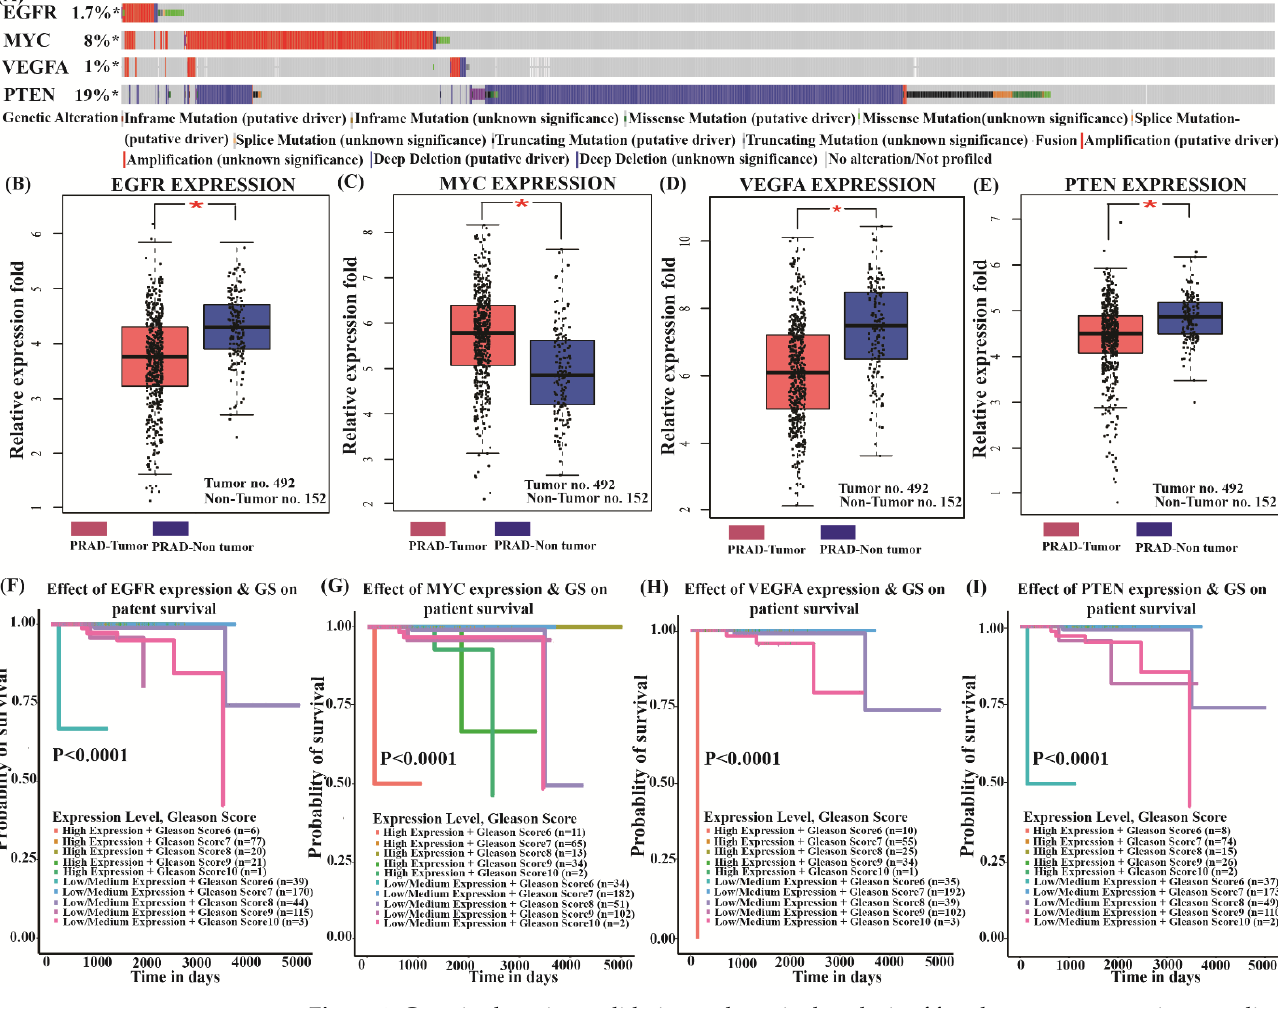
Figure 8. Genetic alteration, validation and survival analysis of four key genes expression paradigm related to PCa using TCGA data. ( A ) The oncoplot of four key genes. ( B – E ) The validation of four key genes expression paradigm in PRAD ( n = 492) tumor and non-tumor ( n = 152). ( F – I ) Survival analysis of four key genes associated with PCa using Kaplan Meier method, * Significant p -value < 0.05.